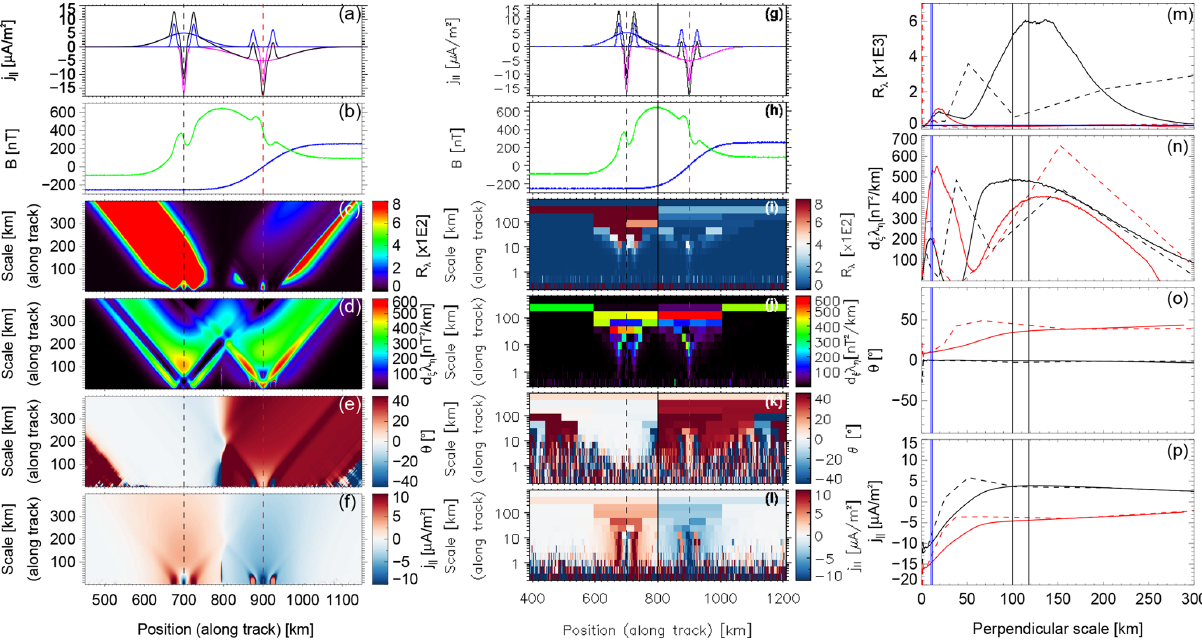
Figure 2. Same panels as in Fig.